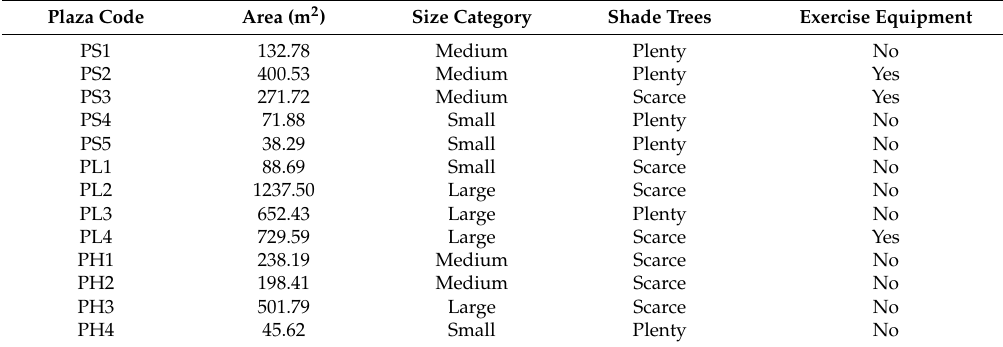
Table 3. Attributes of plaza settings in the parks.